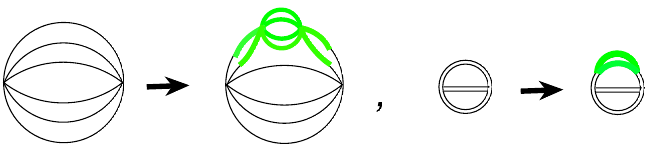
Figure 15 . An example of the recursive generation of dominant ( O ( n 4 )) vacuum diagrams. The process is shown in terms of the in(cid:13)ated single line propagators and vertices on the left; and in terms of the original double line notation on the right. The green part in bold lines is the building block shown in (cid:12)gure 12. Iterating this procedure leads to \melon" graphs of the standard